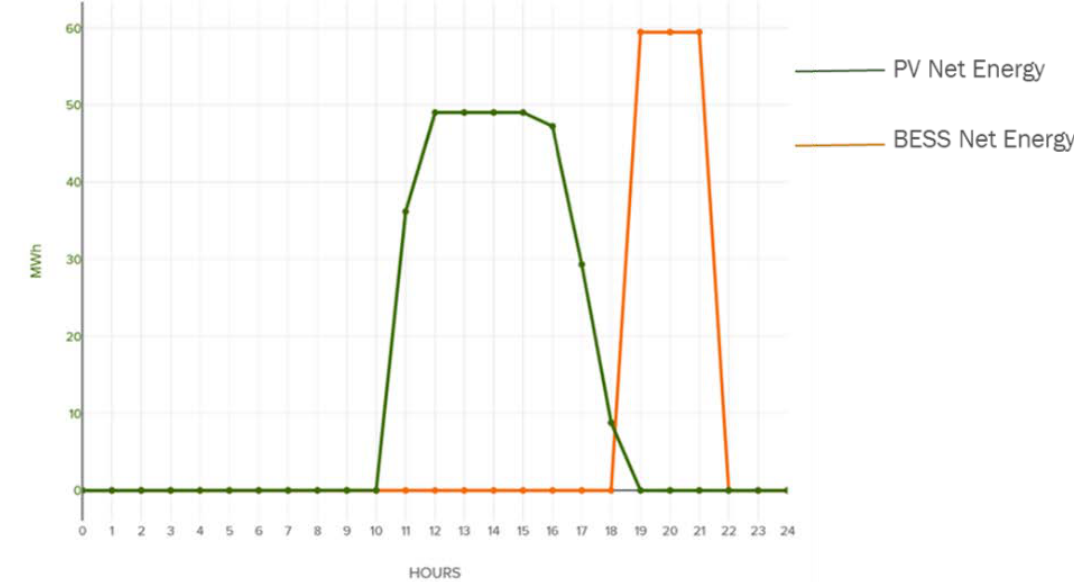
Figure 8. A typical profile for PV and Battery Energy Storage System (BESS) net energy for a typical summer day (27 June) in San Bernardino, California.